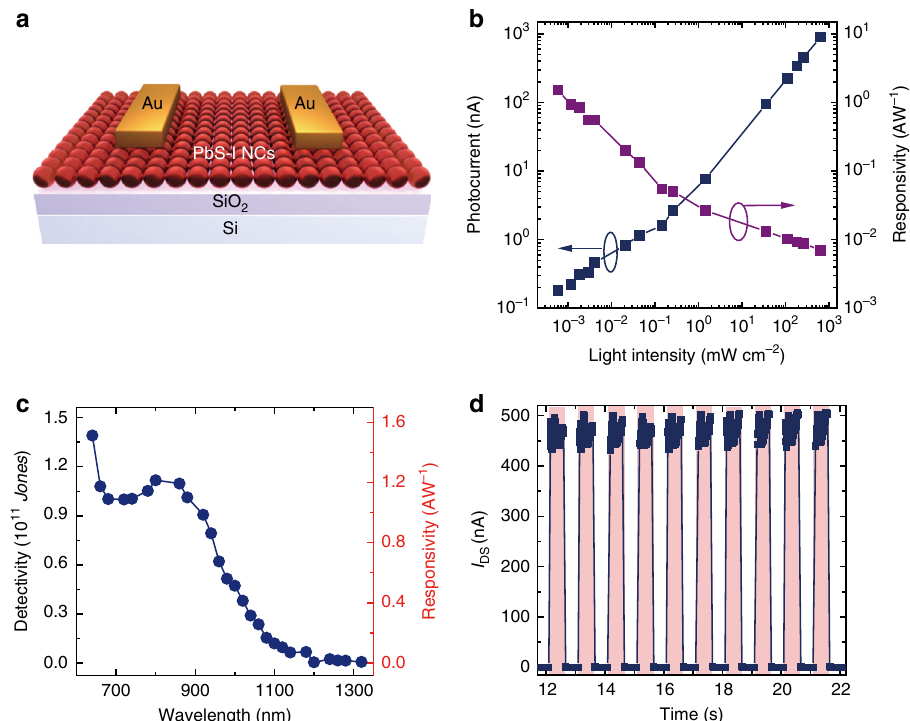
Fig. 4 Photodetectors based on PbS-I NCs. a Scheme of the structure of photodetector devices. b Photocurrent and responsivity under different light intensity of 635 nm laser. c Spectral detectivity and responsivity of PbS-I NCs based photodetectors. d Dynamic response of the device upon on-off switching of 635 nm laser. The measurements are carried out at a drain bias of 5 V and without gate